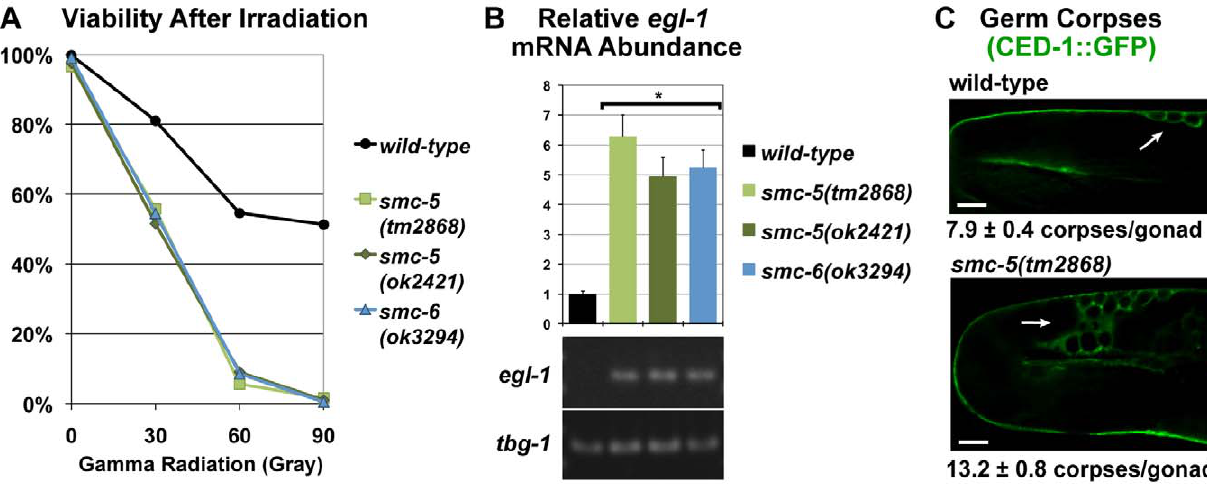
Figure 3. Loss of function mutations in smc-5 and smc-6 conferred hypersensitivity to ionizing radiation (IR) and increased DNA- damage responses in germ cells. (A) Graph of the viability of the eggs produced from mock and radiation-exposed germ cells in mutant F1 and wild-type L4-stage larvae as described [31]. 297 eggs or more were counted for each genotype and at each dose of IR. (B) Relative mRNA abundance for egl-1 after normalization to gamma tubulin tbg-1 as measured by quantitative RT-PCR [32]. Error bars represent standard errors. The asterisks (*) indicate significant changes from the wild-type control (p , 0.001, t-Test). Gel analysis confirmed the size of each RT-PCR product and is shown underneath the graph. (C) Micrographs of germ cell corpses (white arrows) detected by CED-1::GFP fluorescence showed a greater number of corpses in the smc-5(tm2868) mutant germline. The average number of corpses per gonad and the standard error are indicated. Scale bars=10 m m.